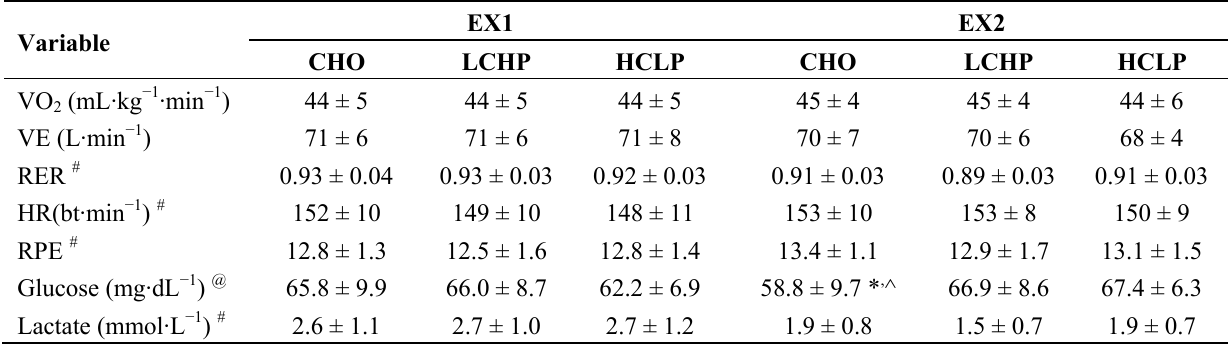
Table 1. Steady State Responses during Exercise (Mean ±